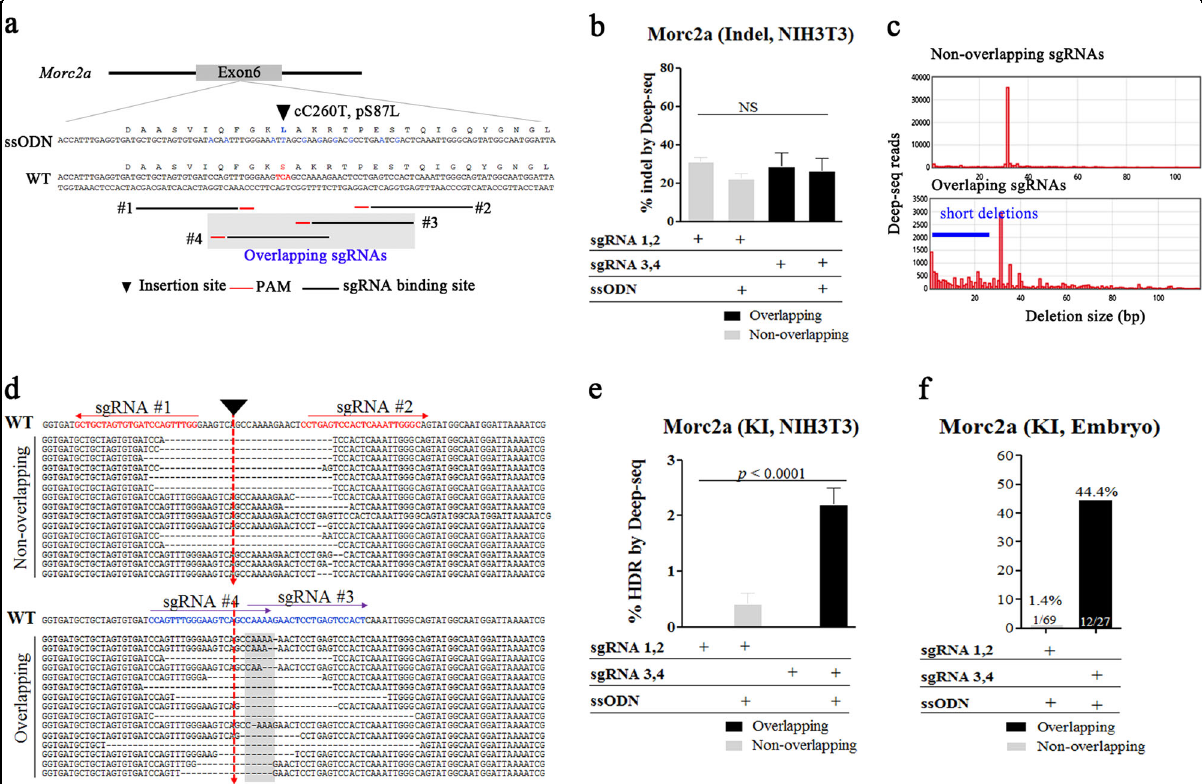
Fig. 3 Ef fi cient incorporation of single-nucleotide substations at the mouse Morc2a locus using overlapping sgRNAs in mouse zygotes and fi broblast cell lines. a Schematic diagram of the strategy for introducing cC260T mutations using a ssODN consisting of 60 nt of homology arms and 45 nt of the insertion sequence containing silent and targeted mutations into exon 6 of the Morc2a locus. The two different sets of sgRNAs (non- overlapping; and overlapping, grey box) are shown. Blue letters indicate nucleotide alteration for amino-acid change or silent mutation for PCR-based KI analysis ( b – e ). Targeted deep sequencing of gDNAs from NIH-3T3 cells transfected with overlapping or non-overlapping sgRNAs containing Cas9 mRNA and ssODN sequences. b Percentages of NHEJ-induced indels. c Distribution of sequence-deletion sizes associated with the use of overlapping or non-overlapping sgRNAs. d Fifteen most frequent deletion patterns. Red and blue alphabets indicate sgRNA binding sites, red arrows indicate target sites for loxP insertion, and gray box indicate overlapping region, and ( e ) HDR-mediated KIs. The p- values were calculated using Student ’ s t - test. f 3 days after microinjection of overlapping or non-overlapping sgRNAs with Cas9 mRNA and ssODNs, PCR-based ssODN-mediated KI ef fi ciency was measured and is represented as bar graphs. KI (%) indicates the ratios of KI embryos derived from total